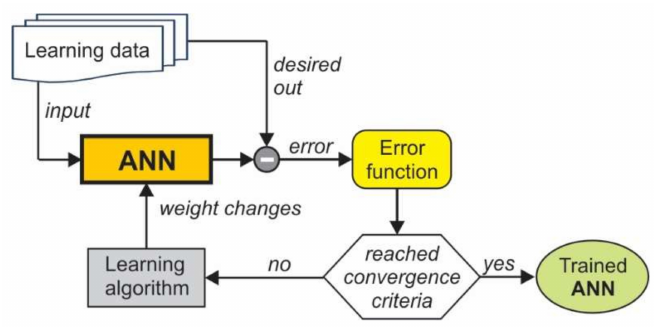
Figure 3. Supervised learning